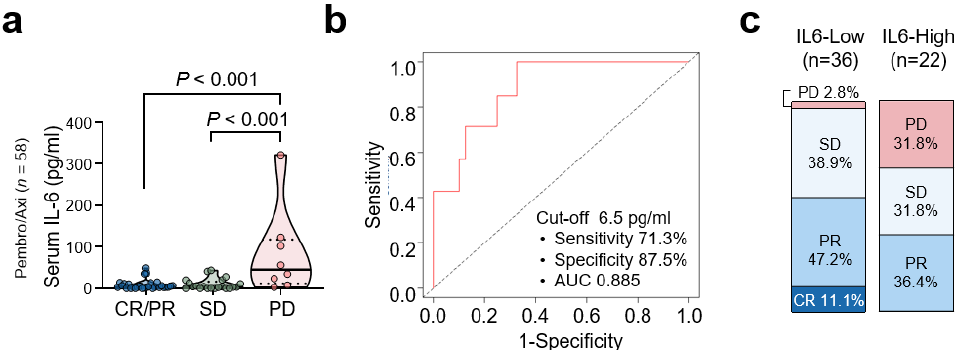
Figure 2. Baseline serum IL-6 levels and survival outcome with pembrolizumab/axitinib therapy. ( a ) Comparison of IL-6 levels according to the best response. Values were compared using ANOVA with Tukey’s post hoc test with respective p -values given in each plot. ( b ) Time-dependent receiver operator characteristic curve of serum IL-6 levels. ( c ) Bar charts showing the best response to therapy by IL-6 level. Table 2. Association between baseline IL-6 levels and patient characteristics.